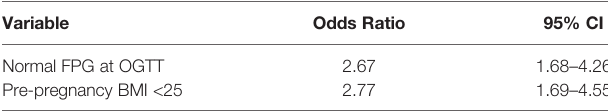
TABLE 6 | Variables signi fi cantly associated to rapid analogues insulin treatment for GDM from multivariate stepwise logistic regression. Variable